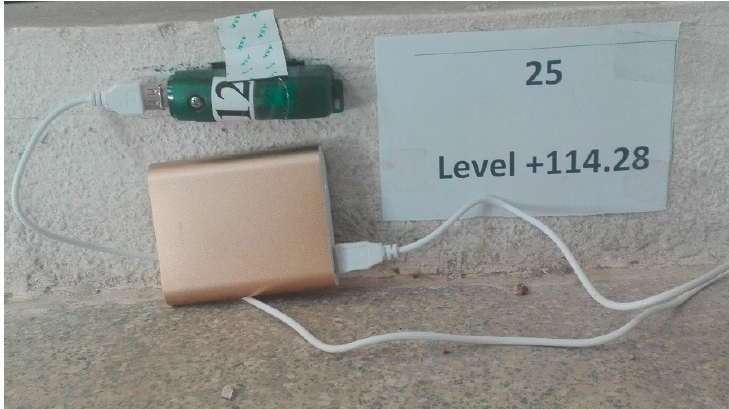
Figure 3. Accelerometer with an additional power arrangement.